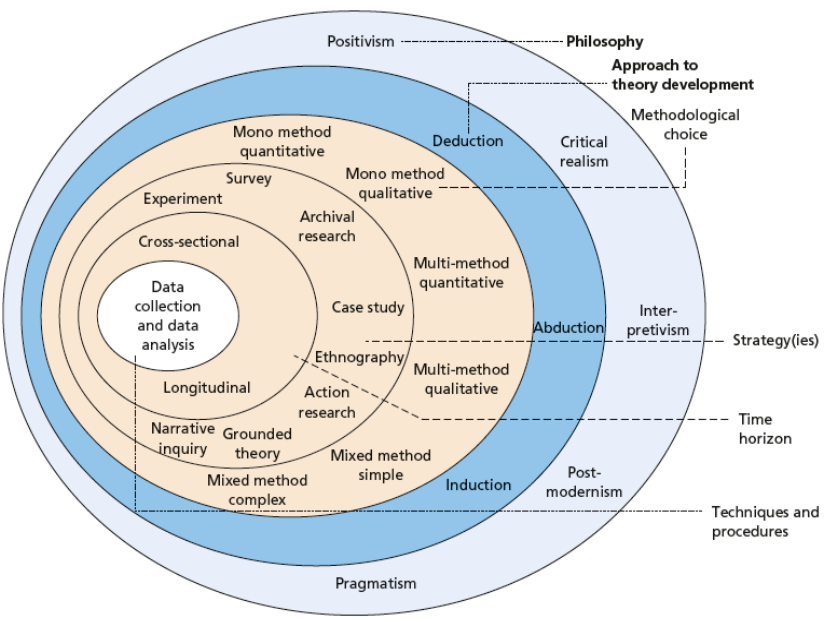
Figure 2. Saunders et al.’s Research Onion [30].